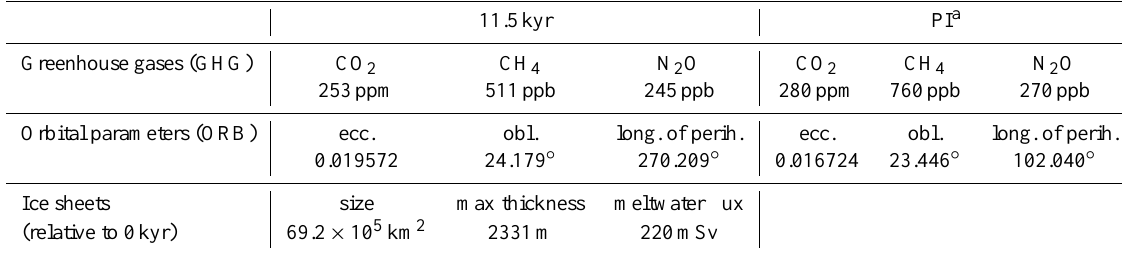
Table 1. Boundary conditions for 11.5kyr and the preindustrial (PI) era